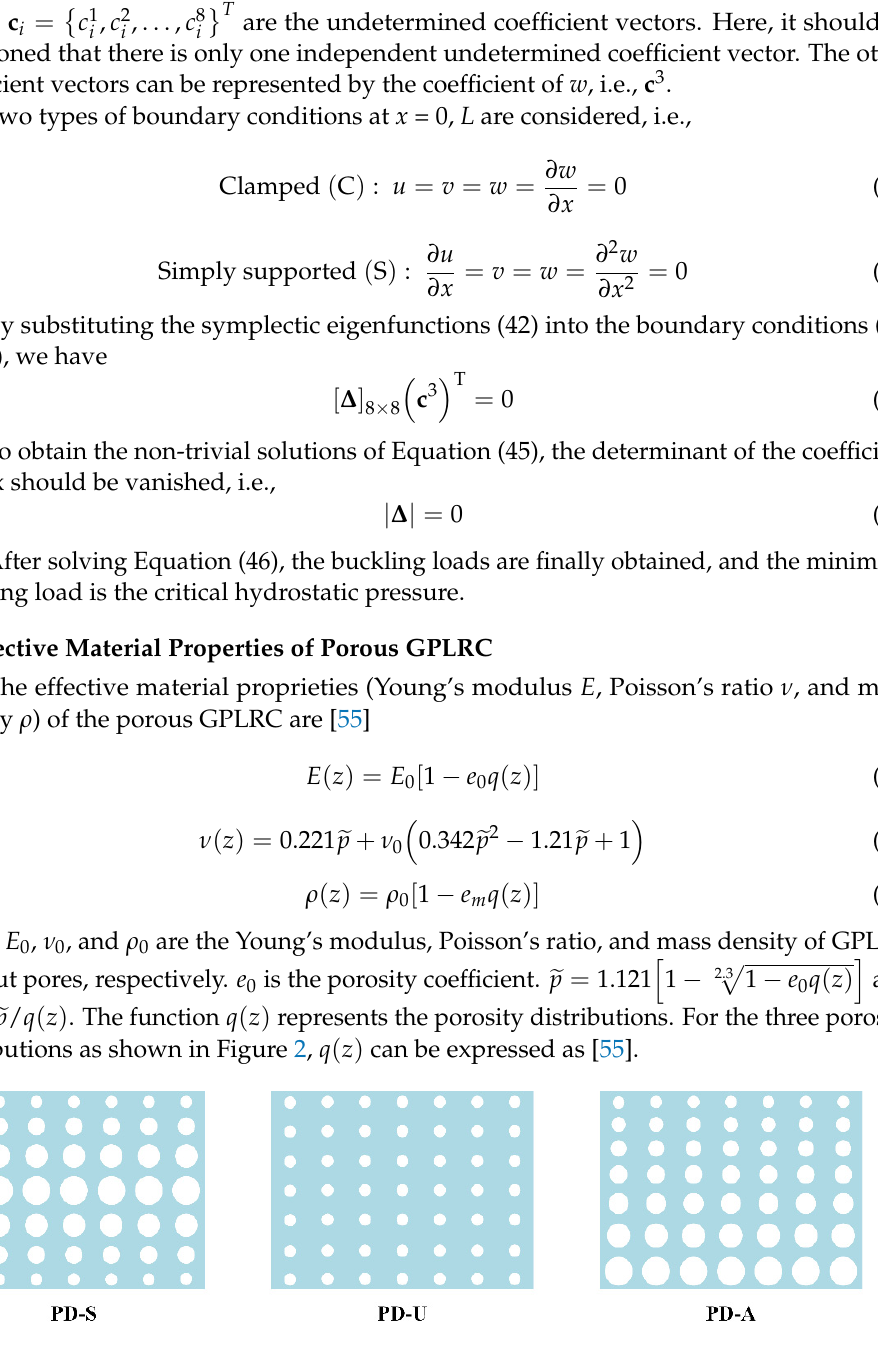
Figure 2. Schematic of porosity distributions.